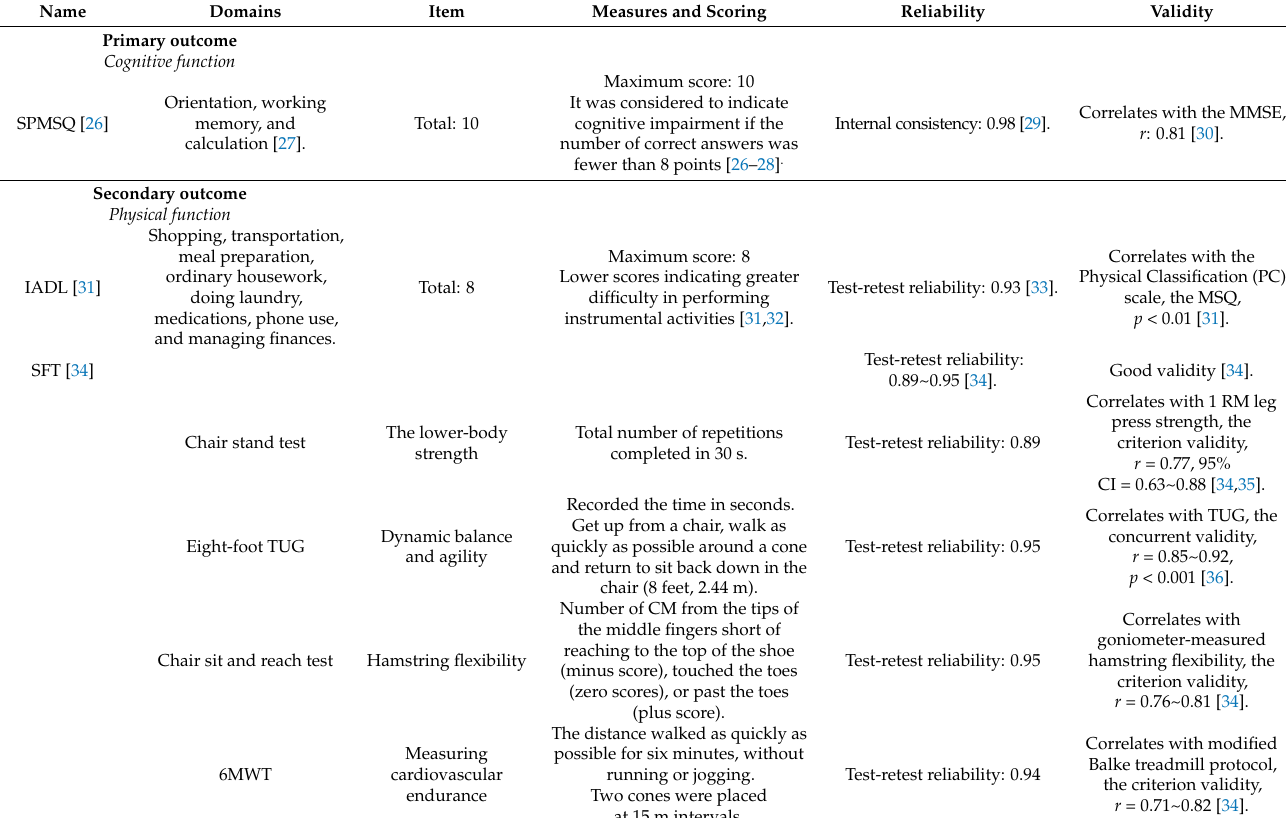
Table 2. Description of the preliminary outcomes